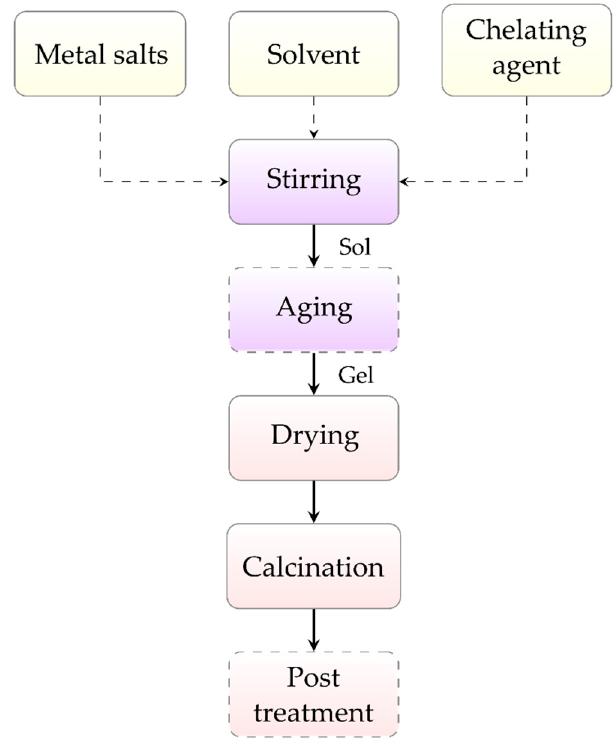
Figure 18. A simple flowchart of the sol-gel process.